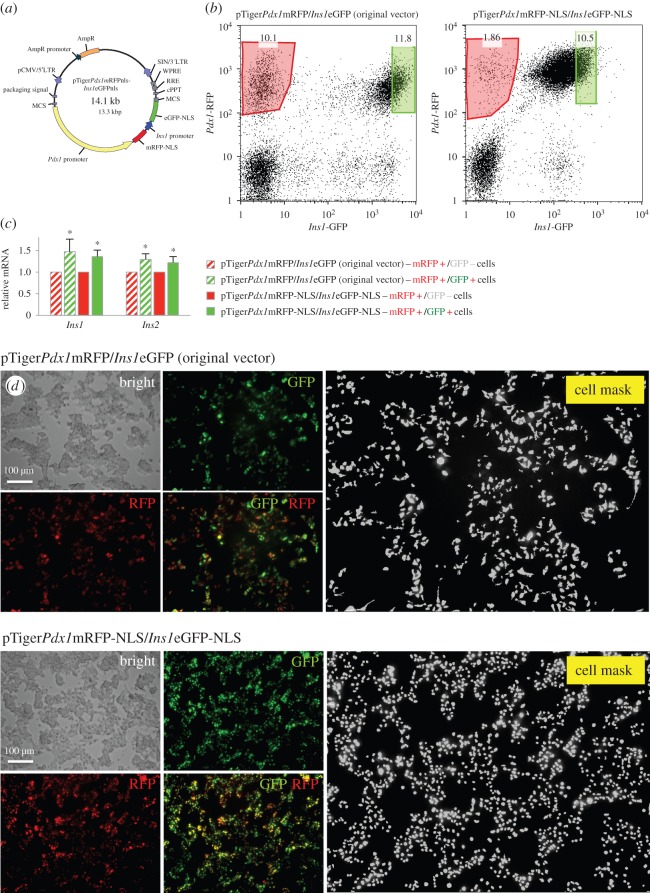
Targeting fluorescent reporters for Pdx1 and Ins1 to the nucleus and validation. (a) Nuclear localization sequences were added to mRFP and eGFP fluorescent proteins for nuclear targeting. (b) FACS plots of MIN6 cells infected with the original Pdx1/Ins1 dual-reporter vector expressing cytoplasmic fluorescent proteins (left panel), and the new Pdx1/Ins1 dual-reporter vector expressing nuclear-targeted fluorescent proteins (right panel). (c) Insulin1 and insulin2 mRNA were measured by qRT-PCR in vector-infected, FACS-purified Pdx1+/Ins1− cells and Pdx1+/Ins1+ MIN6 cells (n=3), *p<0.05. Pdx1 mRNA was not different between these cell populations. (d) Original Pdx1/Ins1 dual-reporter vector labelled the cytoplasm of MIN6 cells (top panels), whereas the new nuclear-targeted reporters mark only the nucleus of labelled cells (bottom panels).